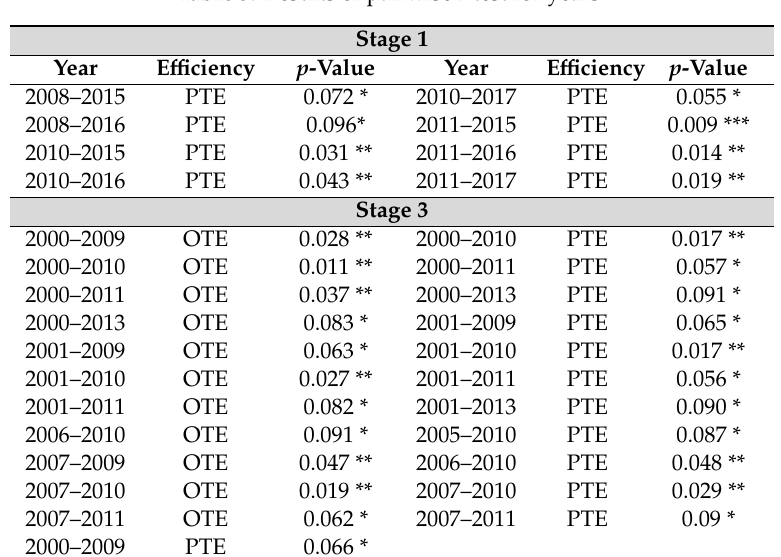
Table 5. Results of pairwise t -test for